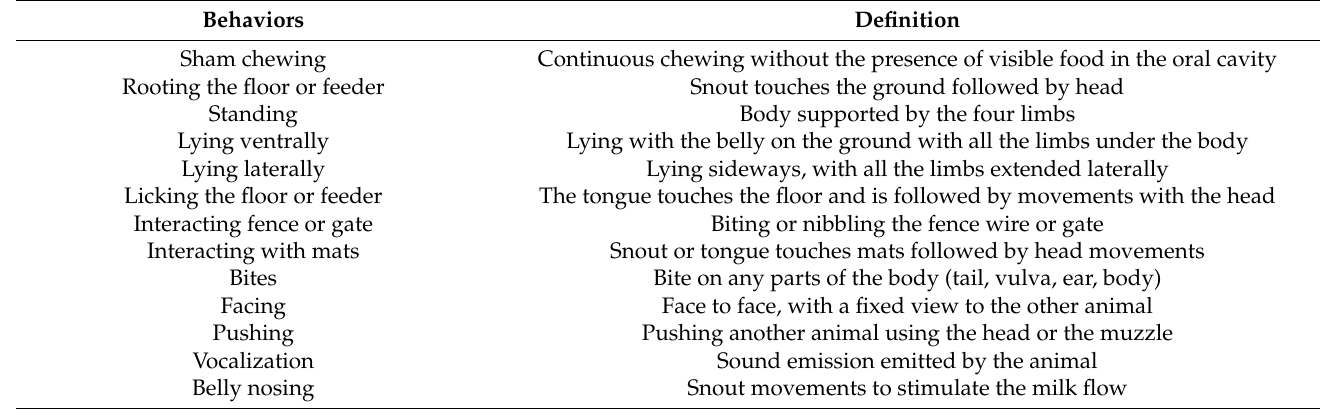
Table 1. Definition of behaviors for behavioral observation of pregnant sows a